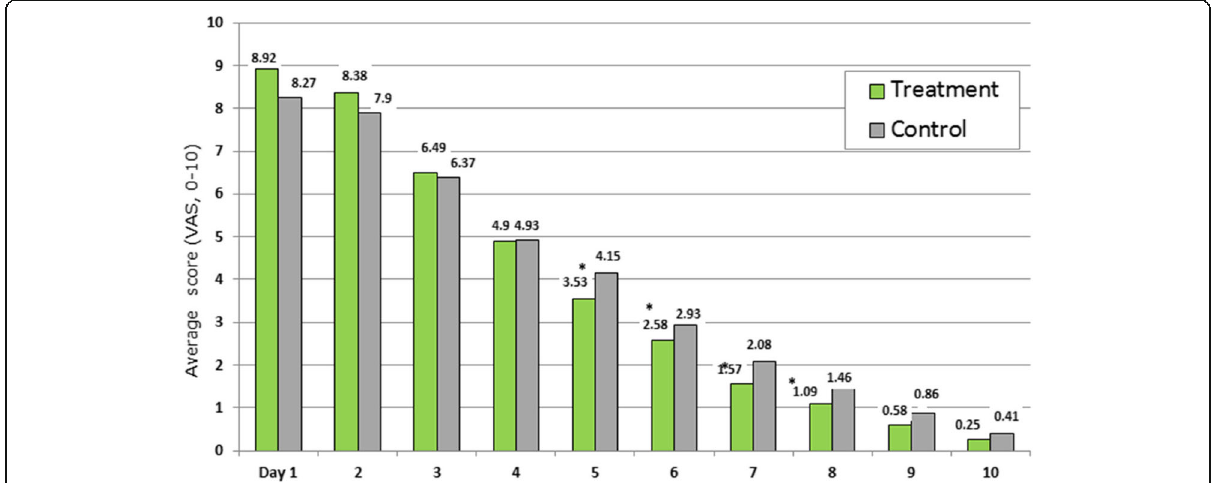
Fig. 5 Patients ’ self-assessment of their condition during the first 10 days of the treatment for three symptoms (rhinorrhea, facial pain, and headache). * p < 0.05: Significant difference between